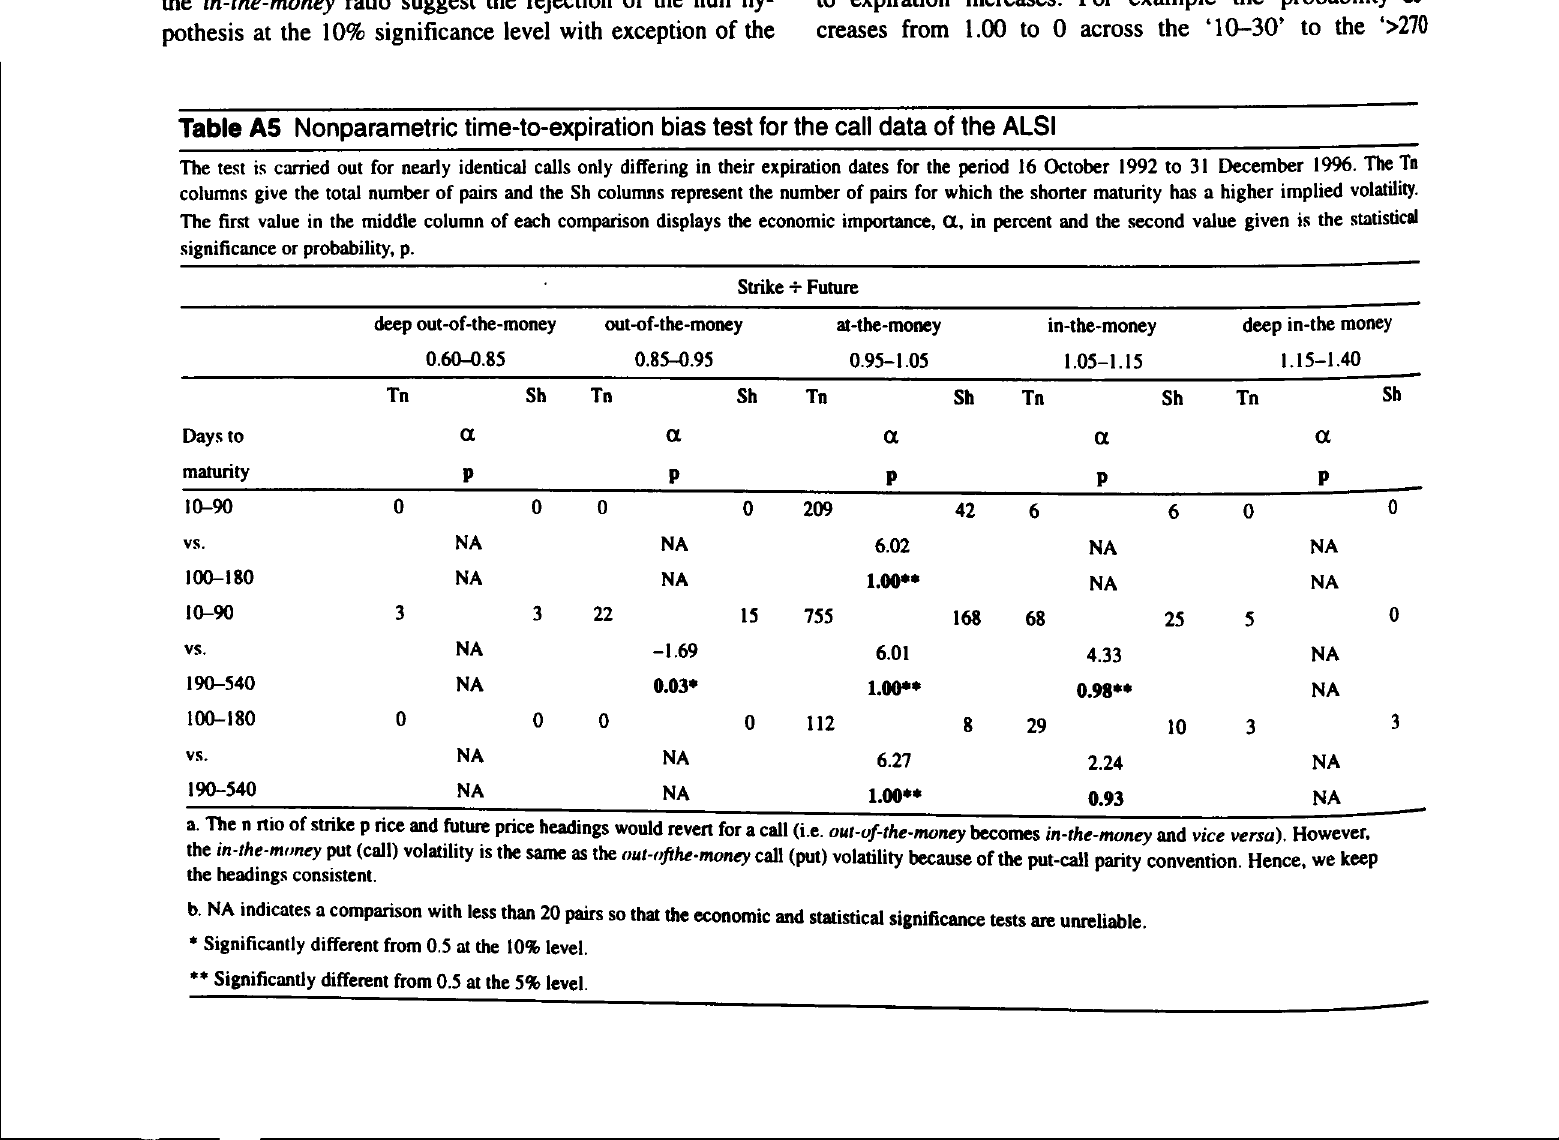
Table AS Nonparametric time-to-expiration bias test for the call data of the ALSI The test is carried out for nearly identical calls only differing in their expiration dates for the period 16 October 1992 to 31 December 1996. The Tn columns give the total number of pairs and the Sh columns represent the number of pairs for which the shorter maturity has a higher implied volatility. The first value in the middle column of each comparison displays the economic importance, a, in percent and the second value given is the statistical significance or probability,